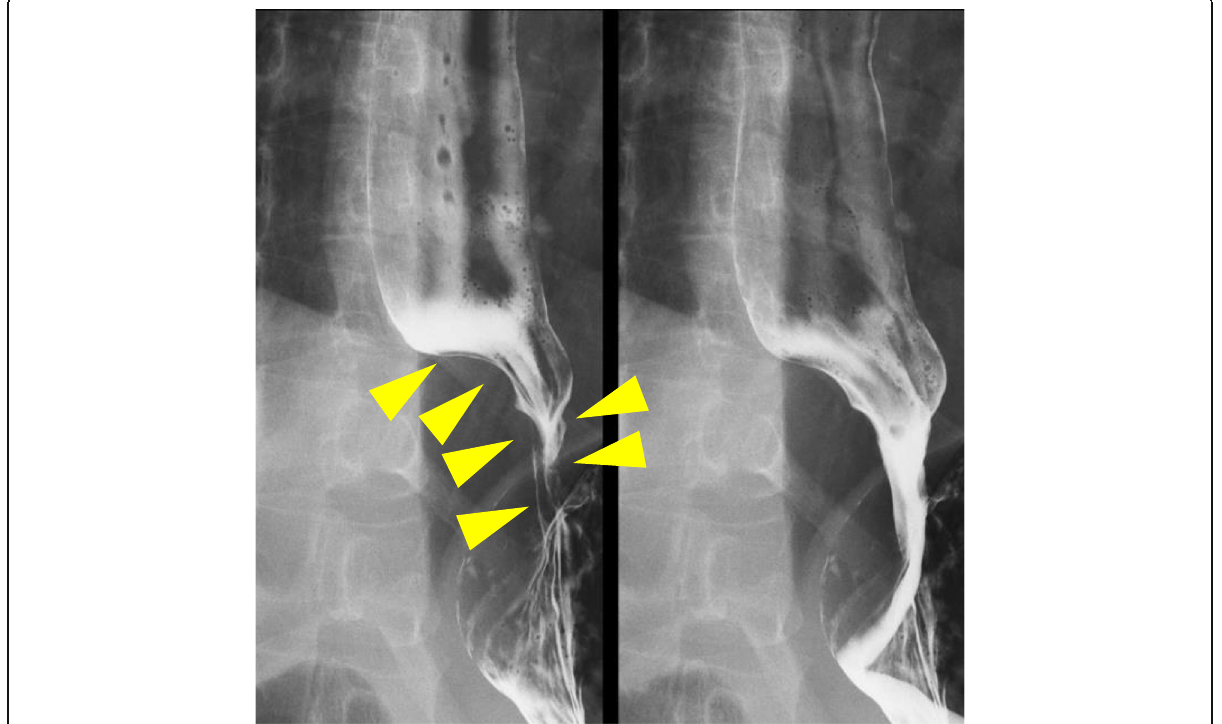
Fig. 3 Esophagography. A 40-mm stenosis owing to the tumor is seen in the lower thoracic